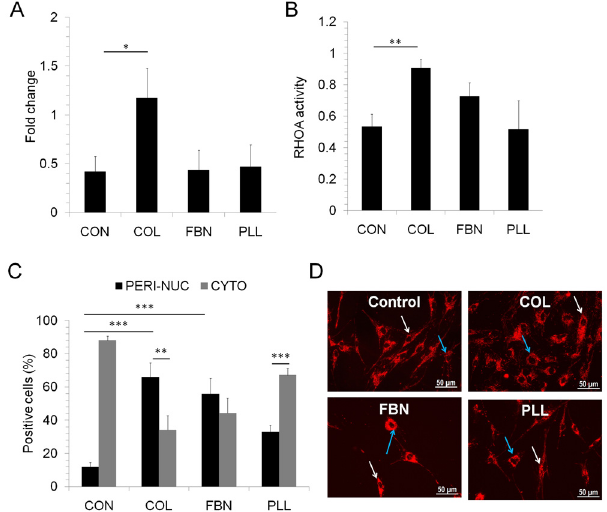
Fig 5. Active RHOA analysis and mitochondria distribution. (A) The RHOA mRNA levels in MSC cultured on TC surface (CON) or COL, FBN, PLL surfaces were determined by real-time PCR analysis. RHOA expression levels were normalised to GAPDH expression levels. (B) Active GTP bound RHOA levels in cells cultured on TC surface (CON), COL, FBN and PLL matrix was determined by RHOA G-LISA activation assay. Values are Mean ± SD, n = 3 samples. (C, D) MSC grown on uncoated (Control, CON), COL, FBN and PLL coated surfaces were stained with TMRE to visualize the distribution of active mitochondria in the cells. (C) The percentage of cells showing cytoplasmic or peri-nuclear distribution was calculated in each condition. (D) Representative microscopic images are shown, blue arrow points to peri-nuclear staining and white arrow points to cytoplasmic staining in each condition. Values are Mean ± SD, n = 6 – 15 (3 samples). * p < 0.05, ** p < 0.005, *** p <